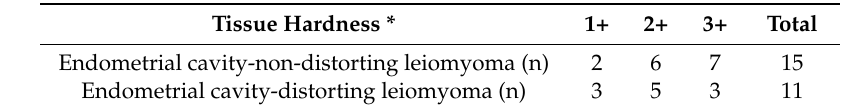
Table 2. Comparison of tissue